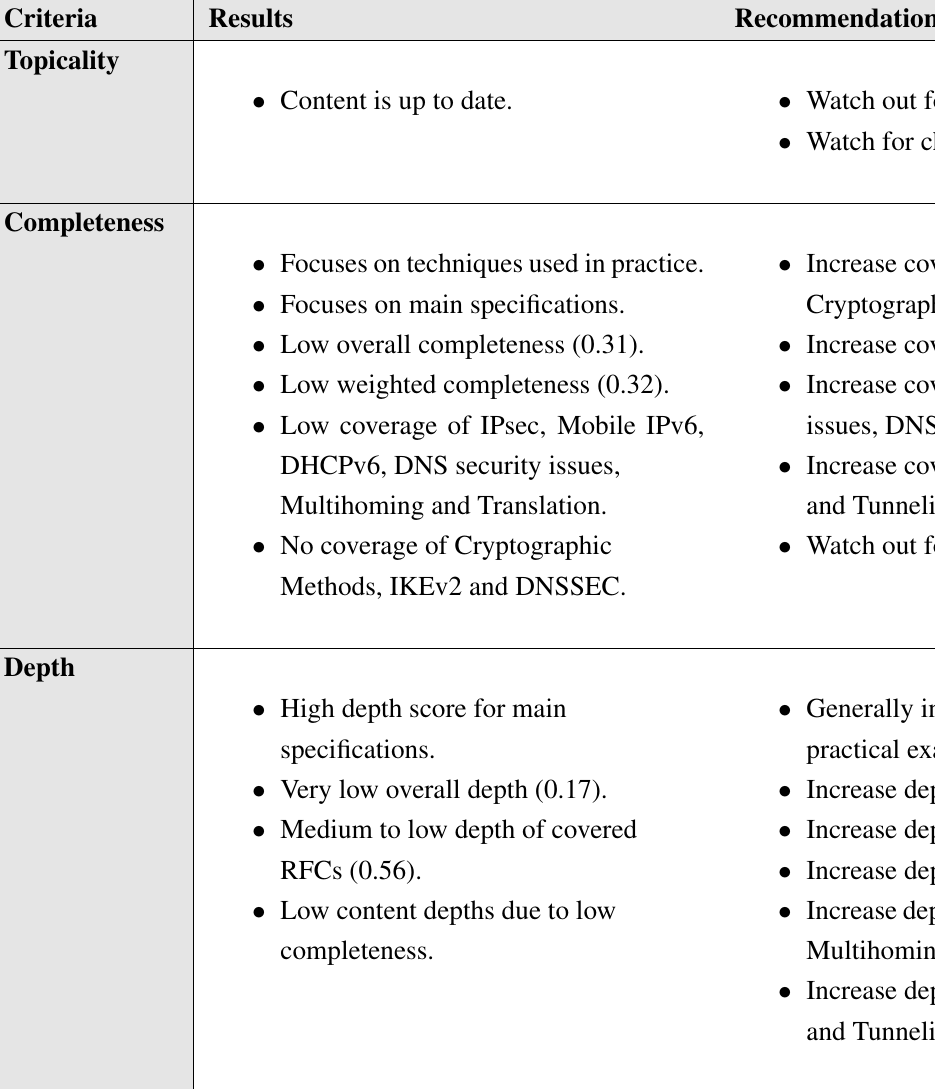
Table 11. BSI—Results and